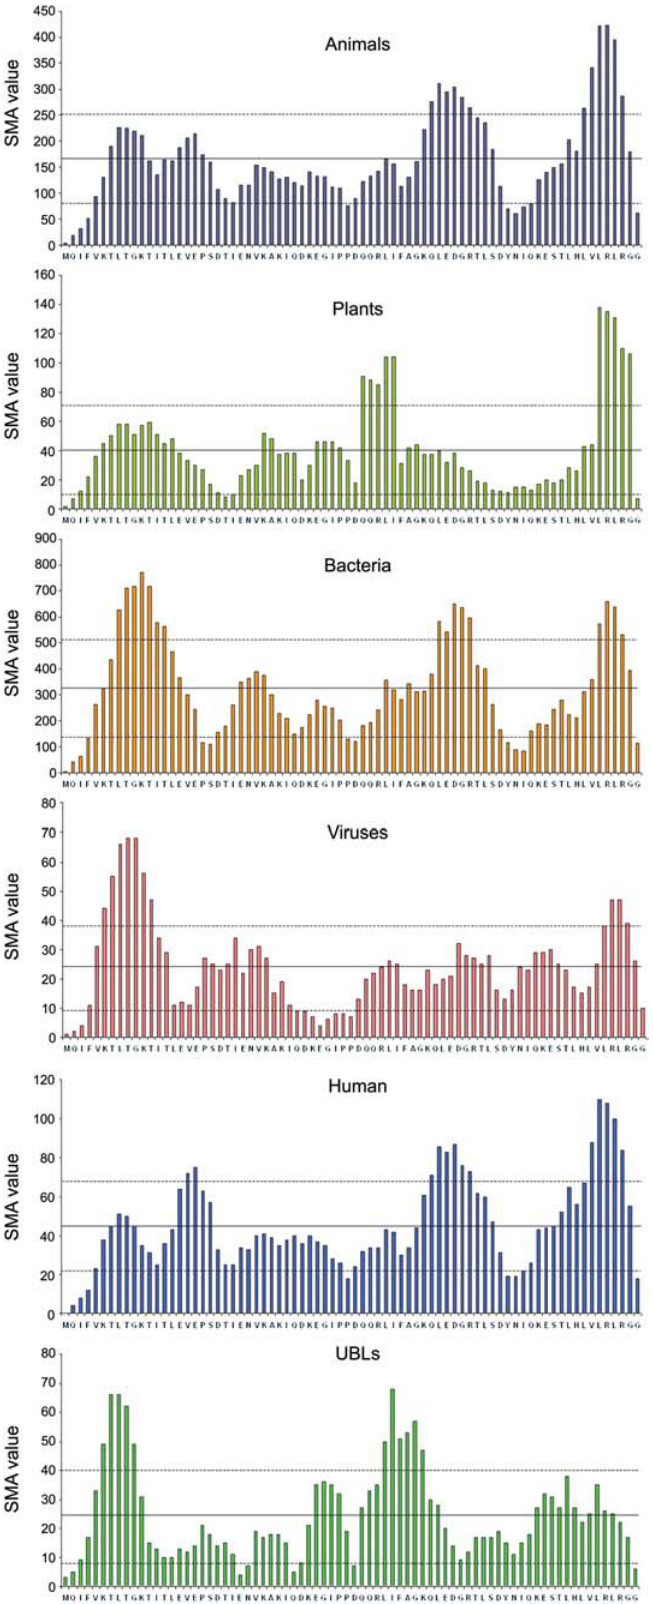
Figure 3 Occurrence of Ub-derived sequences in proteins from certain taxonomic kingdoms, human proteome, and Ub-like protein family. Average SMA values are represented with solid lines, standard deviation ranges are marked with dashed